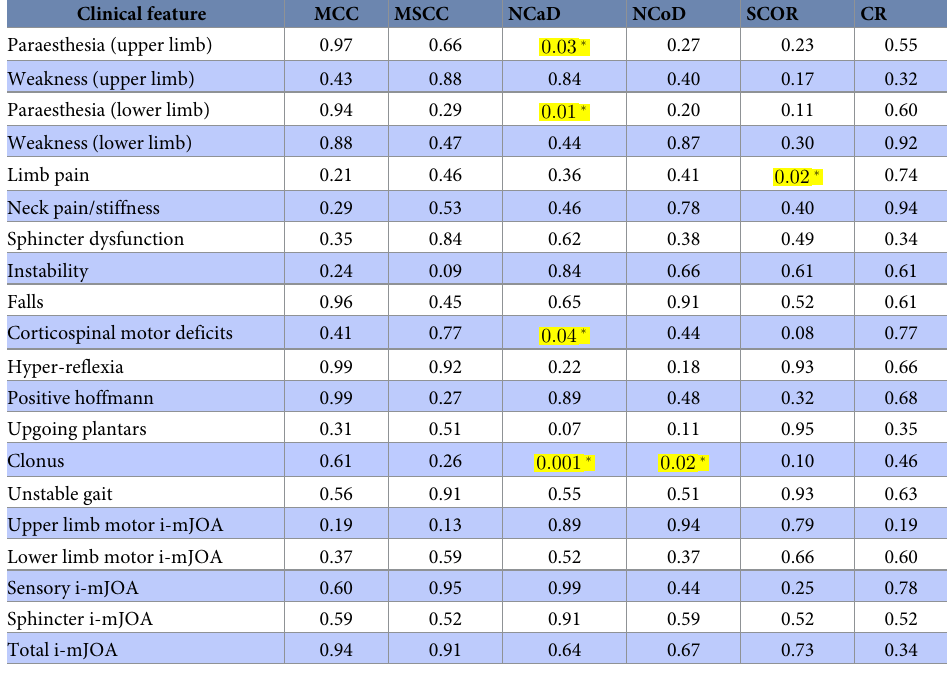
Table 1. The relationships between MRI measurements and clinical features at surgical assessment. Clinical